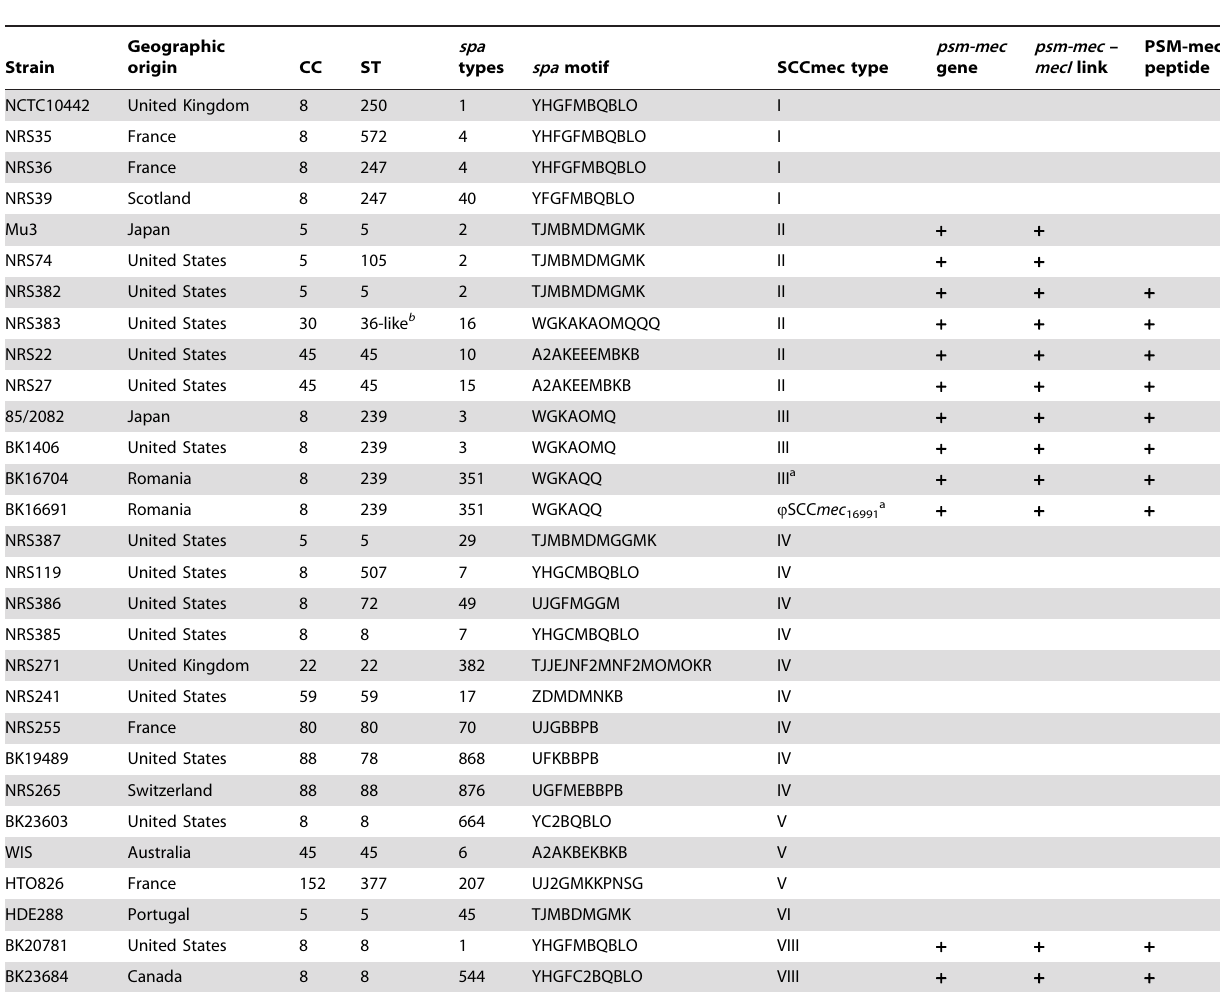
Table 1. Distribution of the psm-mec gene and PSM-mec peptide production in MRSA strains.